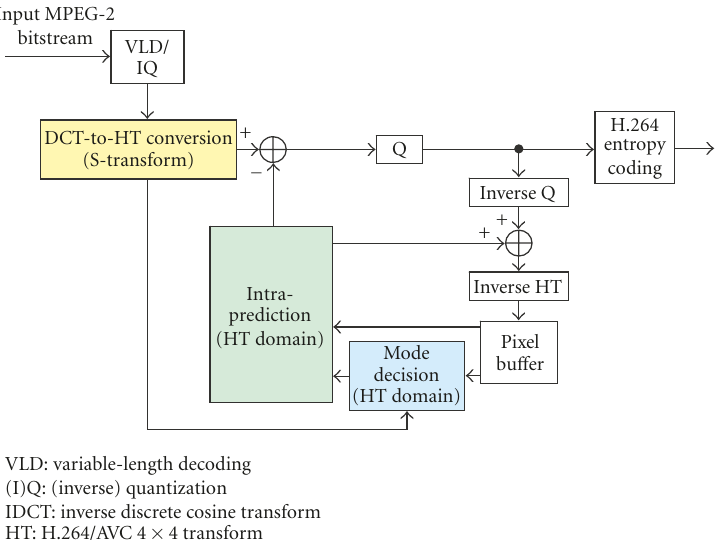
Figure 1: Pixel-domain intra-transcoding architecture.